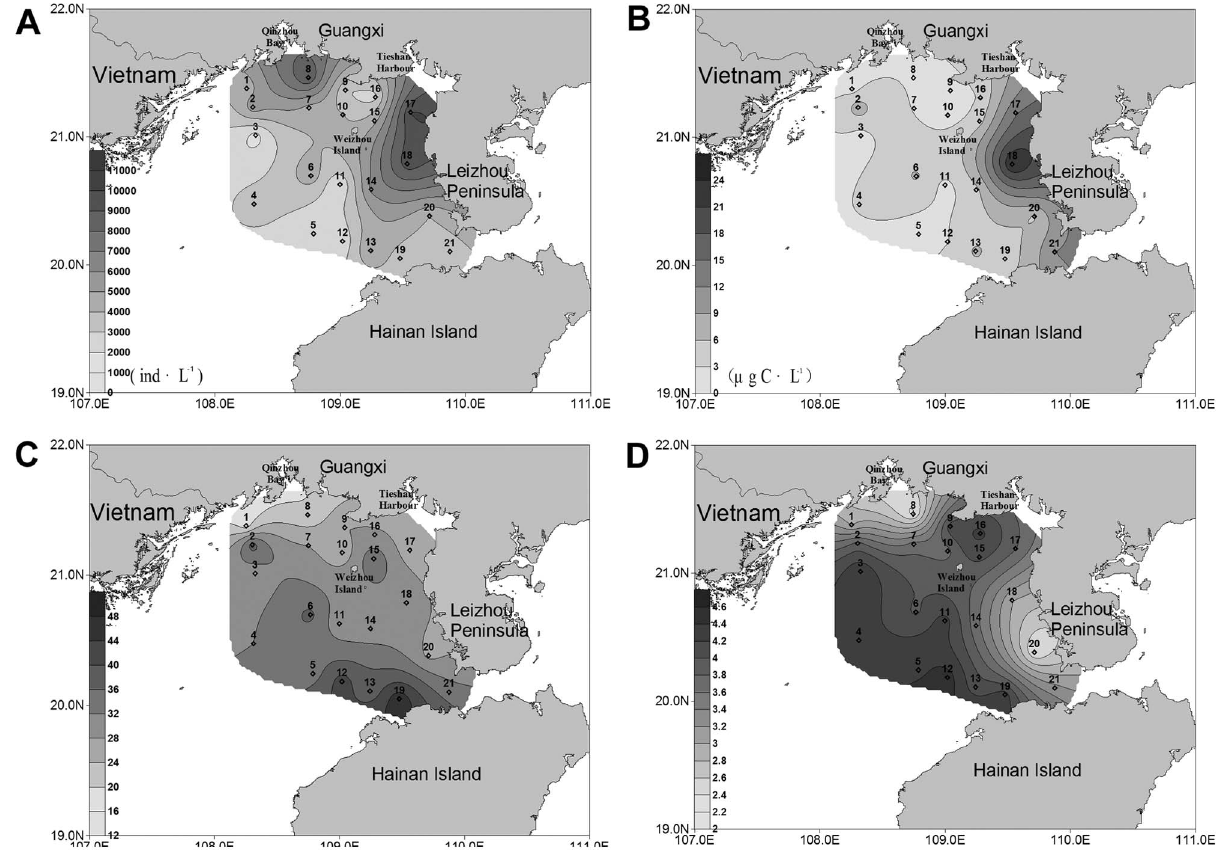
Figure 4. Horizontal distribution of planktonic ciliates in the water columns of the northern Beibu Gulf. (A) Horizontal distribution of abundance. (B) Horizontal distribution of biomass. (C) Horizontal distribution of species number. (D) Horizontal distribution of diversity. The horizontal axis and the vertical axis expressed the gradients in longitude and latitude, respectively. (TIFF).